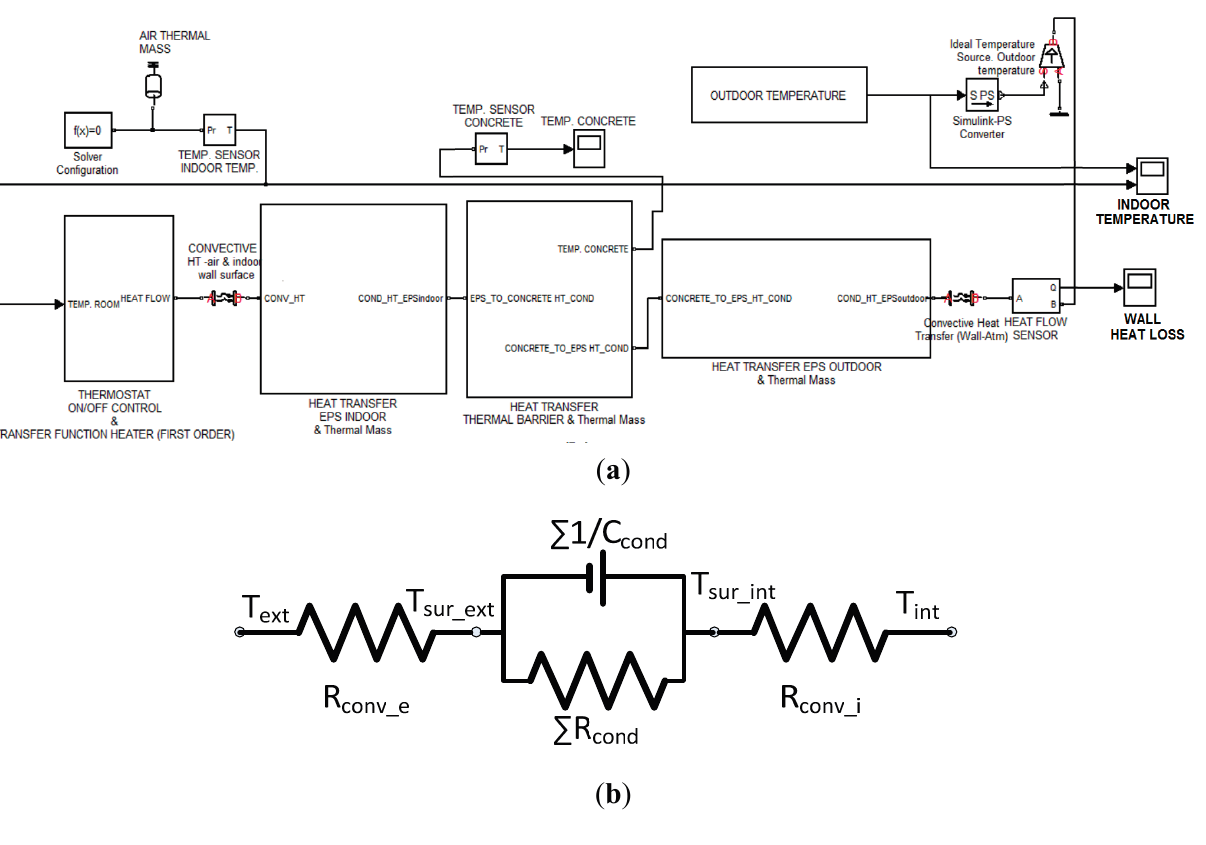
Figure 6. ( a ) Thermal energy transfer model of the experimental building; ( b ) Thermal equivalent